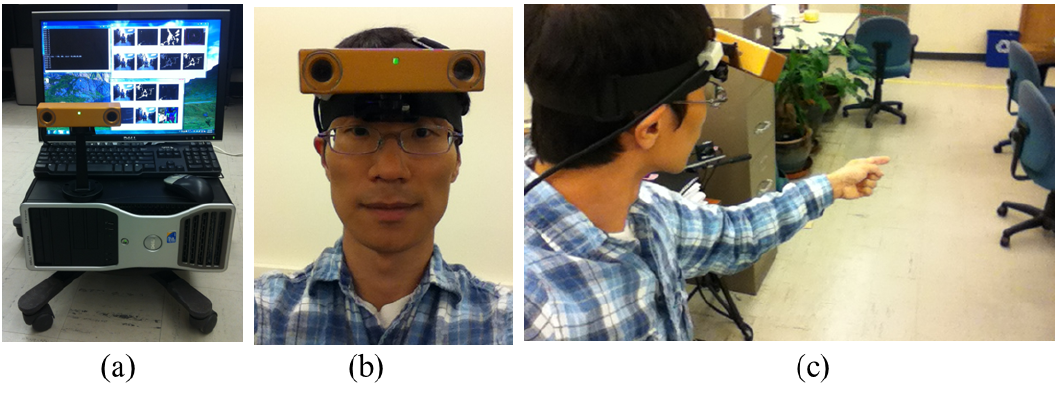
Figure 9. Our developed VIDA system: ( a ) the entire system look; ( b ) an example of the head mounted VIDA system; and ( c ) the user